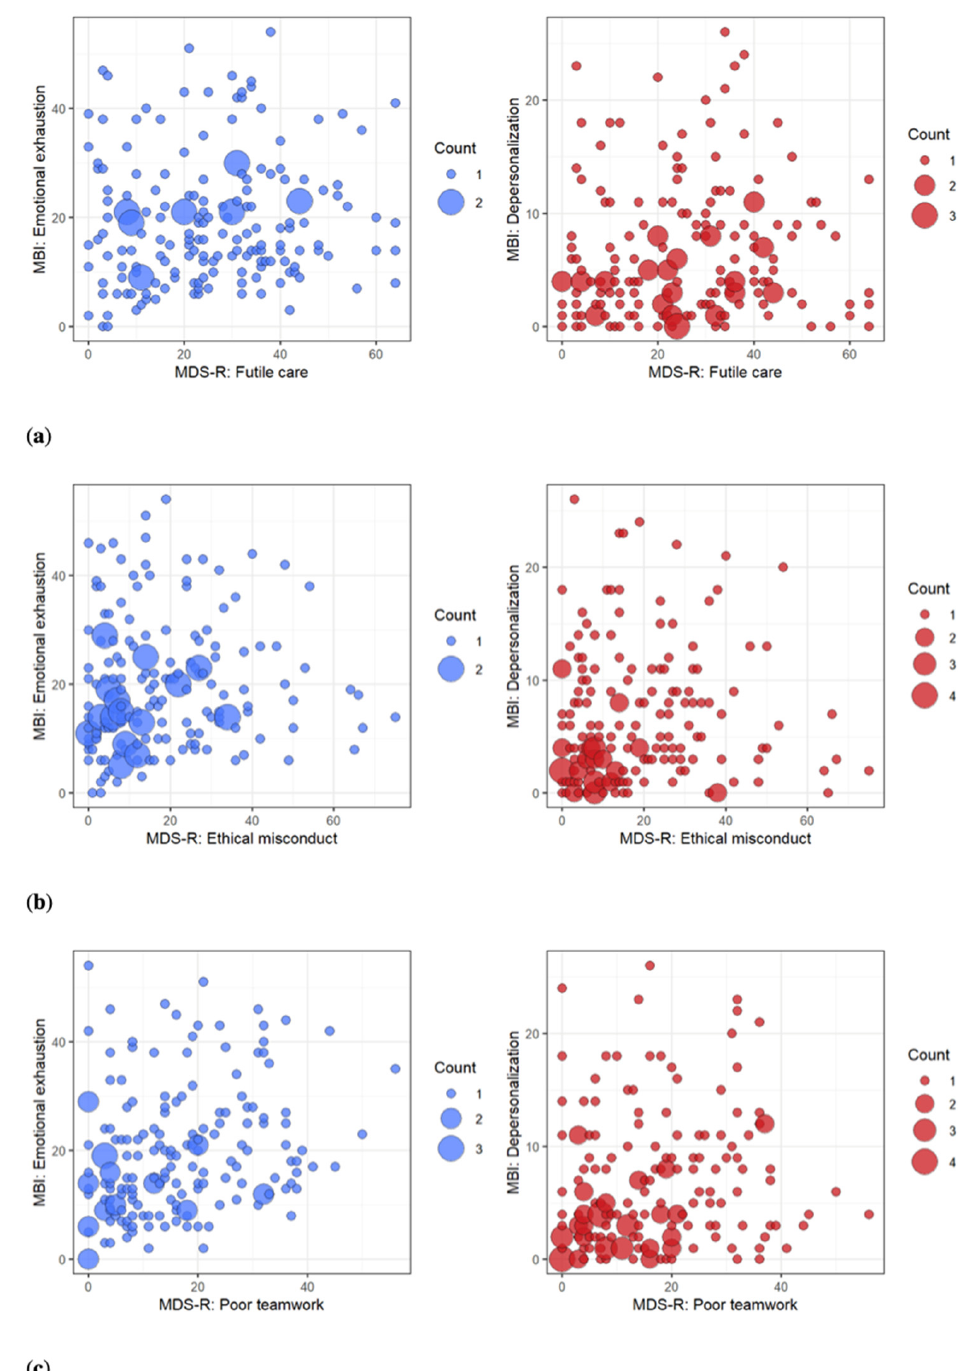
distress and no burnout; subjects with high moral distress and low burnout; subjects with high moral distress and high burnout.